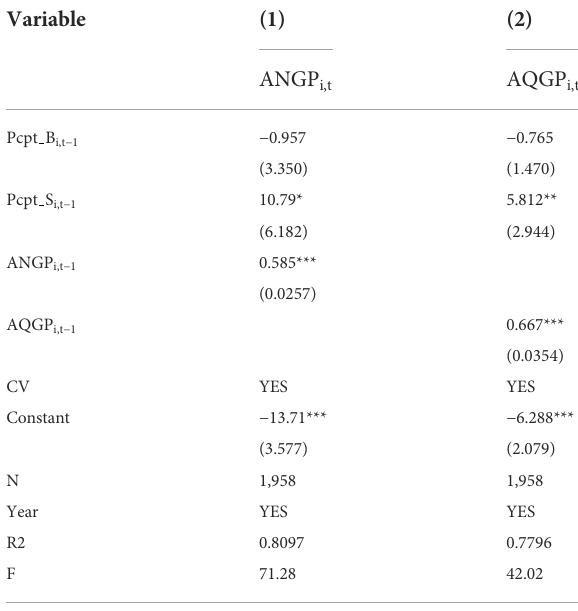
TABLE 8 Test results for the impact of the heterogeneous penalized enterprises on the peer enterprises ’ GTI.